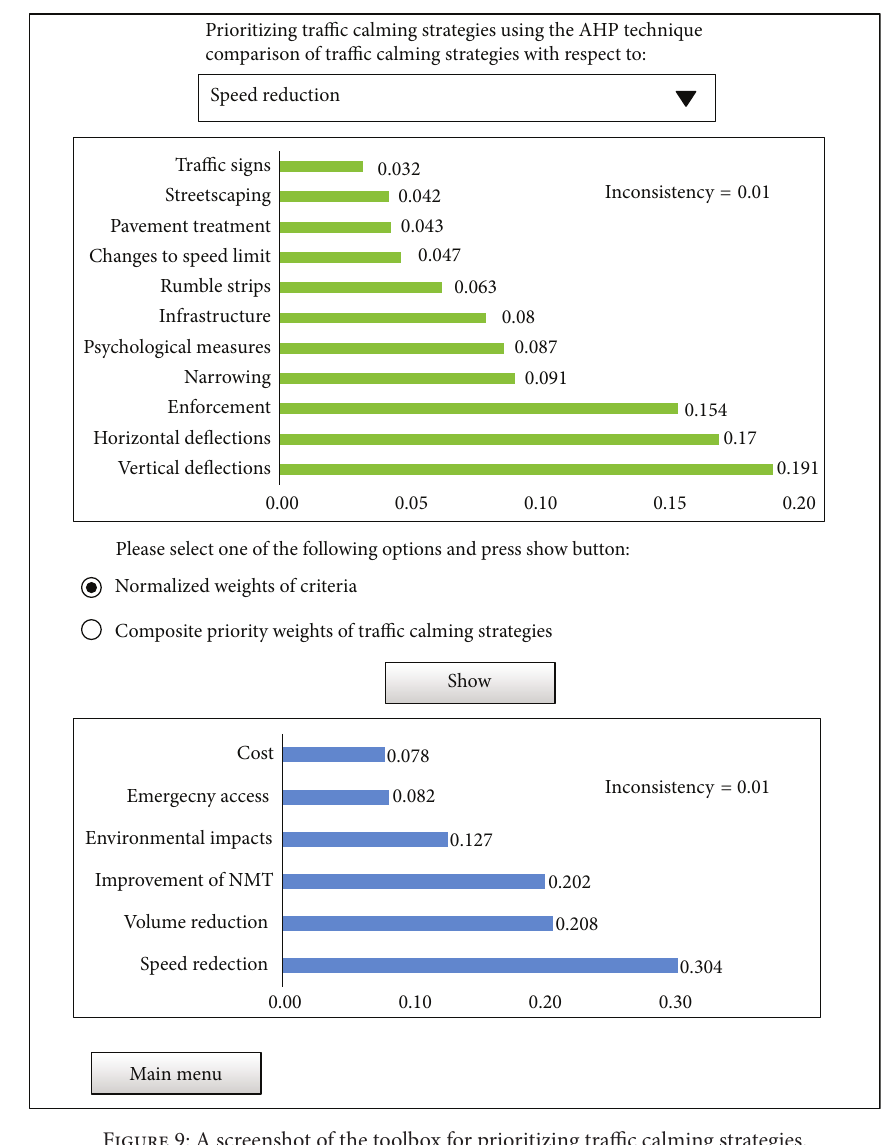
Figure 9: A screenshot of the toolbox for prioritizing traffic calming strategies.